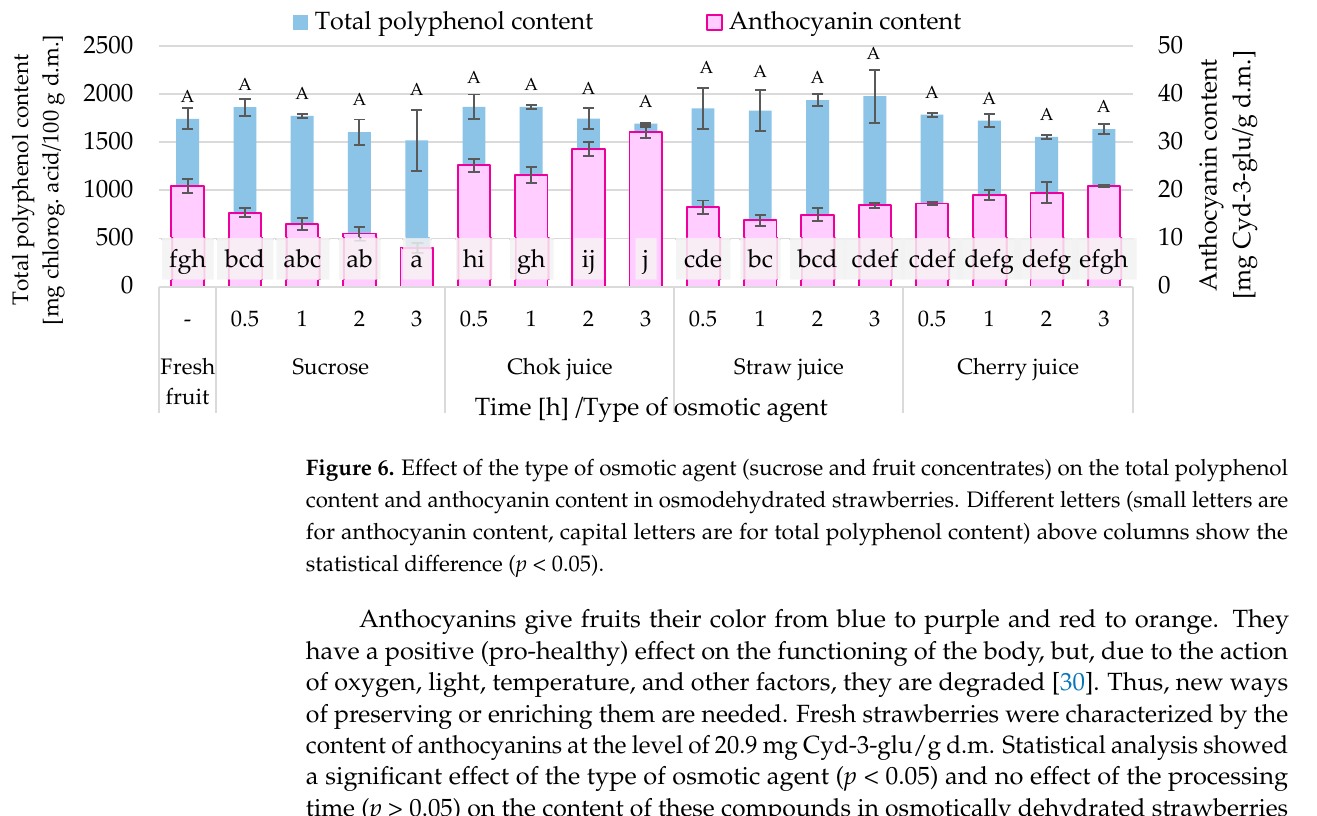
Figure 5. Effect of the type of osmotic agent (sucrose and fruit concentrates) on the vitamin C content in osmodehydrated strawberries. Different letters above columns show the statistical difference ( p < 0.05).